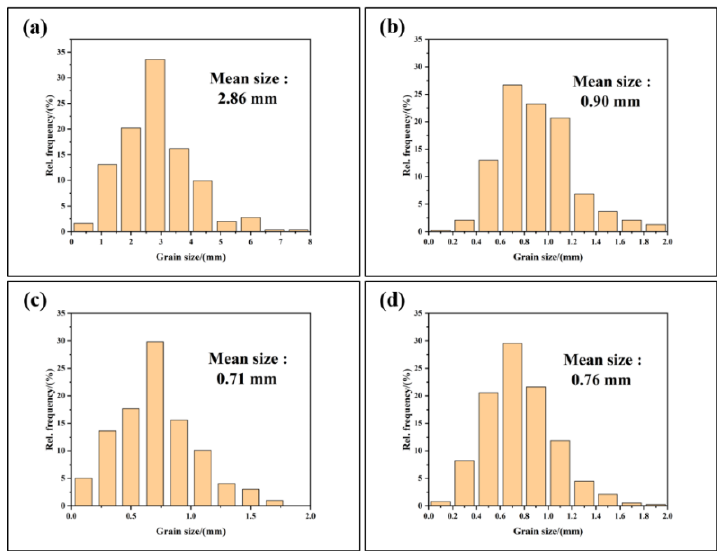
Figure 3. Statistics of grain size of Al-13Si-1Cu alloy with different addition amounts of Al-2Ti-0.5B- 0.5C master alloy: ( a ) A1 alloy, ( b ) A2 alloy, ( c ) A3 alloy, ( d ) A4 alloy.